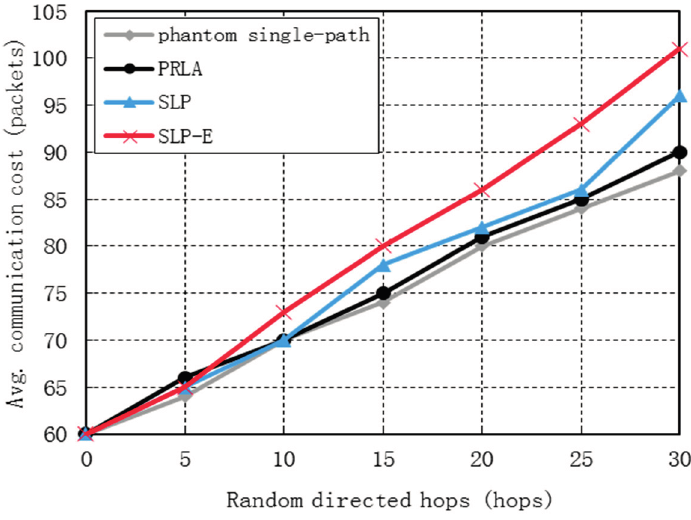
Figure 4. Communication cost vs. random directed